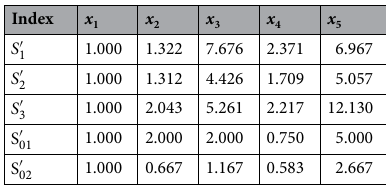
Table 5. Data initialization results.